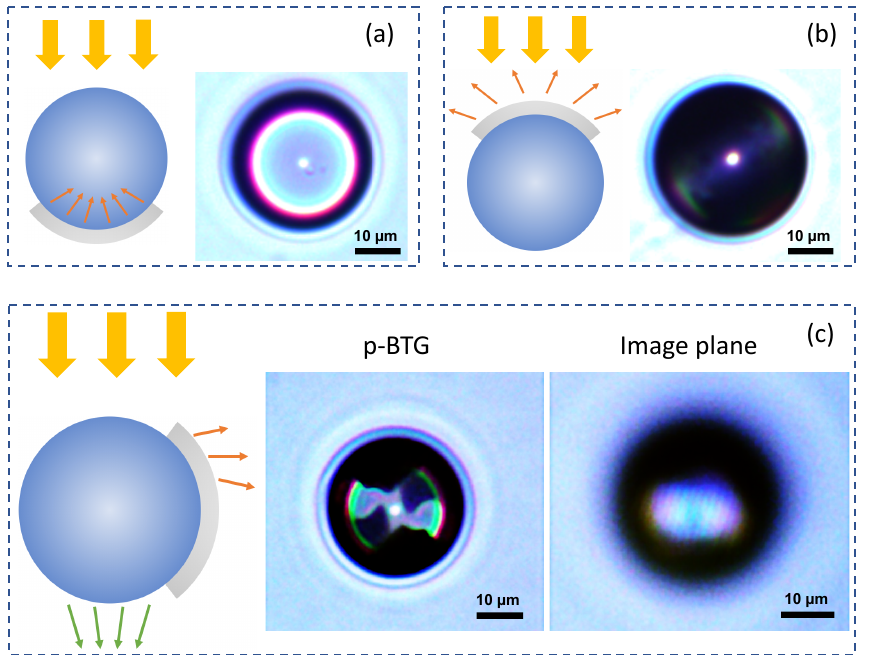
Figure 3. OM images of p-BTG particles when the Ag film is ( a ) at bottom of the microsphere, ( b ) on top of the microsphere, and ( c ) on the side of the